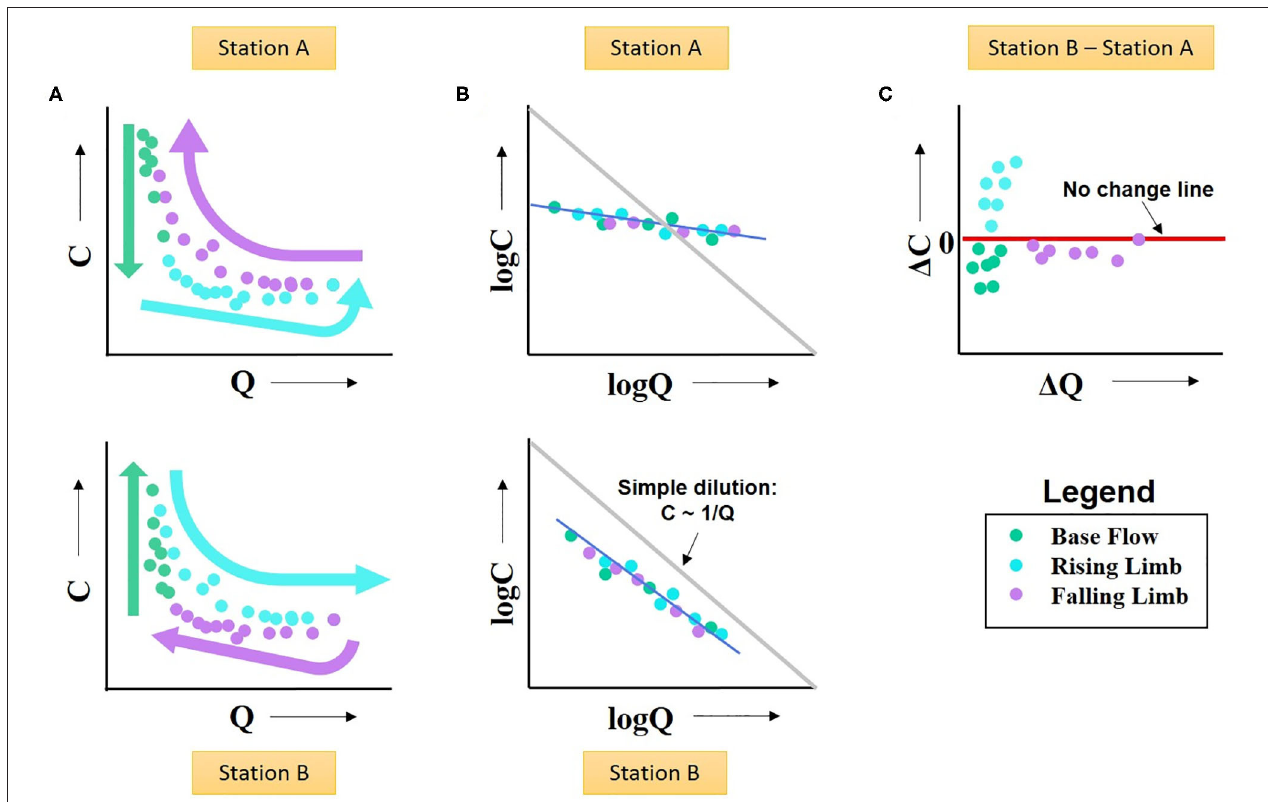
FIGURE 1 | Comparison of concentration-discharge analyses for a hypothetical solute at hypothetical stations A (upstream) and B (downstream) using (A) actual C-Q, (B) log C- log Q, and (C) 1 C- 1 Q. Arrows in (A) indicate direction through time; gray diagonal lines in (B) represent a log-log slope of − 1 indicating dilution and blue lines show linear fits; a red “no change” line is shown in (C) demarcating gains from losses in solute